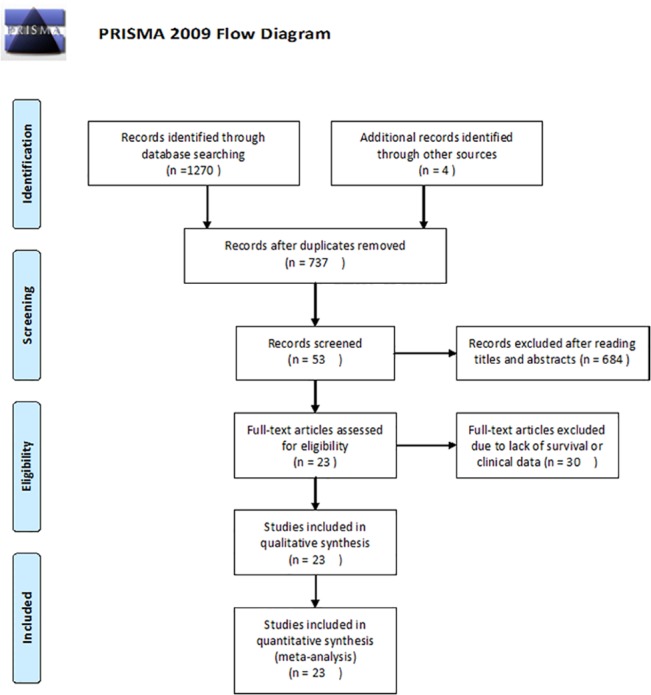
Flow diagram summarizing the selection of eligible studies.